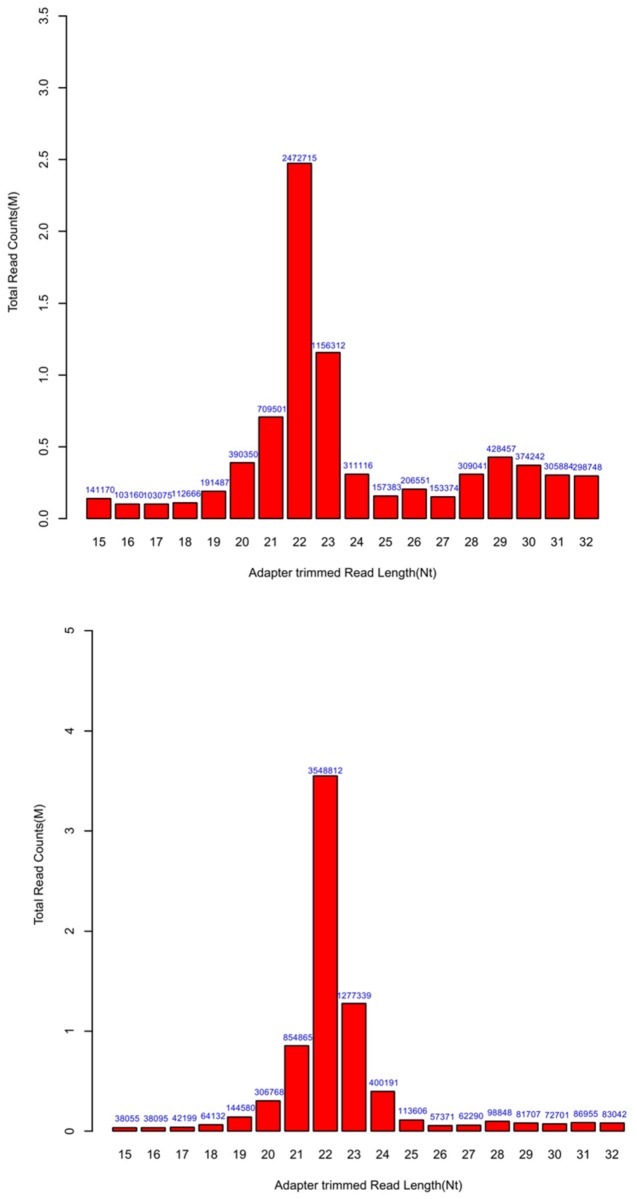
Length distributions of reads.A: The data of ob/ob mouse liver samples. B: The data of wild-type mouse liver samples.